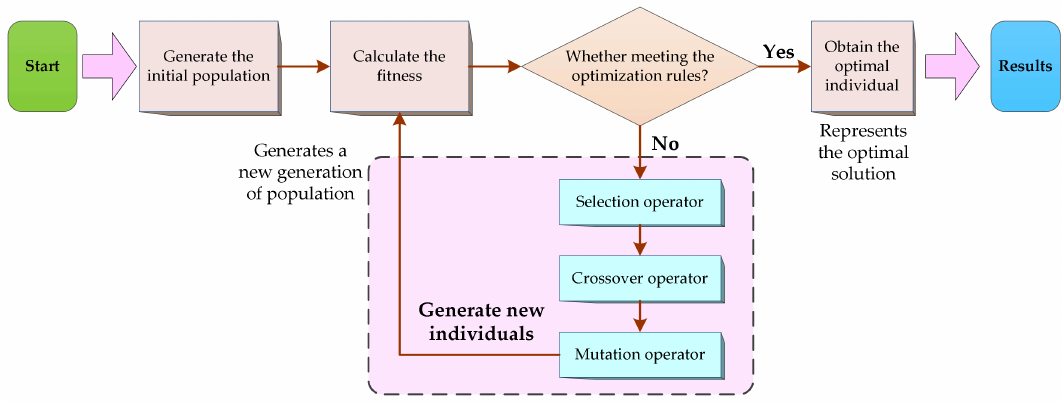
Figure 8. The flow chart of